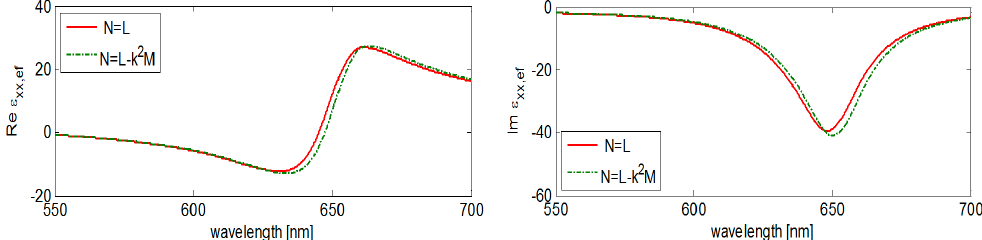
Figure 6. An influence of correction factor k 2 M ⊥ on the real and imaginary part of effective permittivity component ε xx , ef : cylindrical Au nanoparticles in polyacrylate (height/diameter = 50/20 nm, fill factor 0.2).